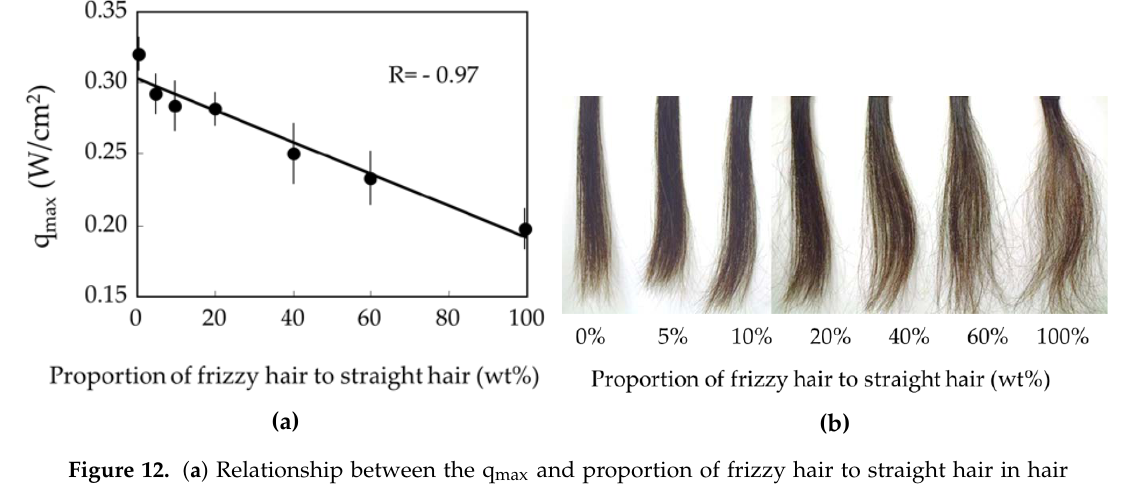
Figure 12. ( a ) Relationship between the q max and proportion of frizzy hair to straight hair in hair swatch. The correlation coefficient (R) was calculated by regression analysis. ( b ) Shape of hair swatches.